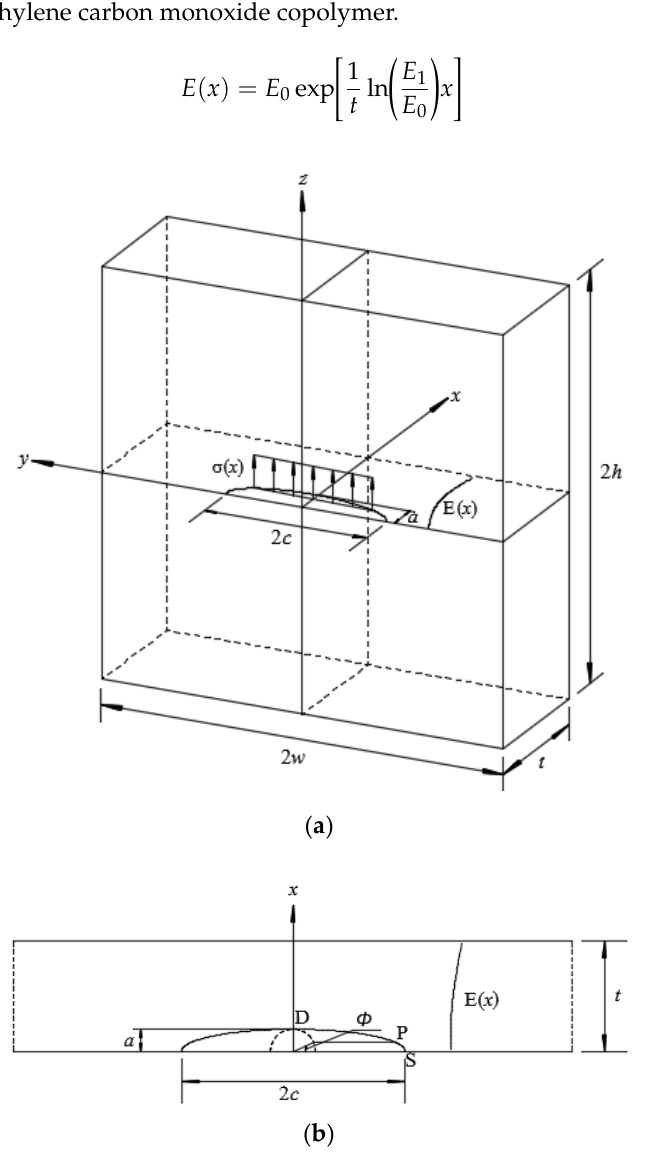
Figure 1. ( a ) Geometry and coordinate system of a functionally graded (FG) plate with a semi-elliptical surface crack subjected to local stress field; ( b ) semi-elliptical surface crack.